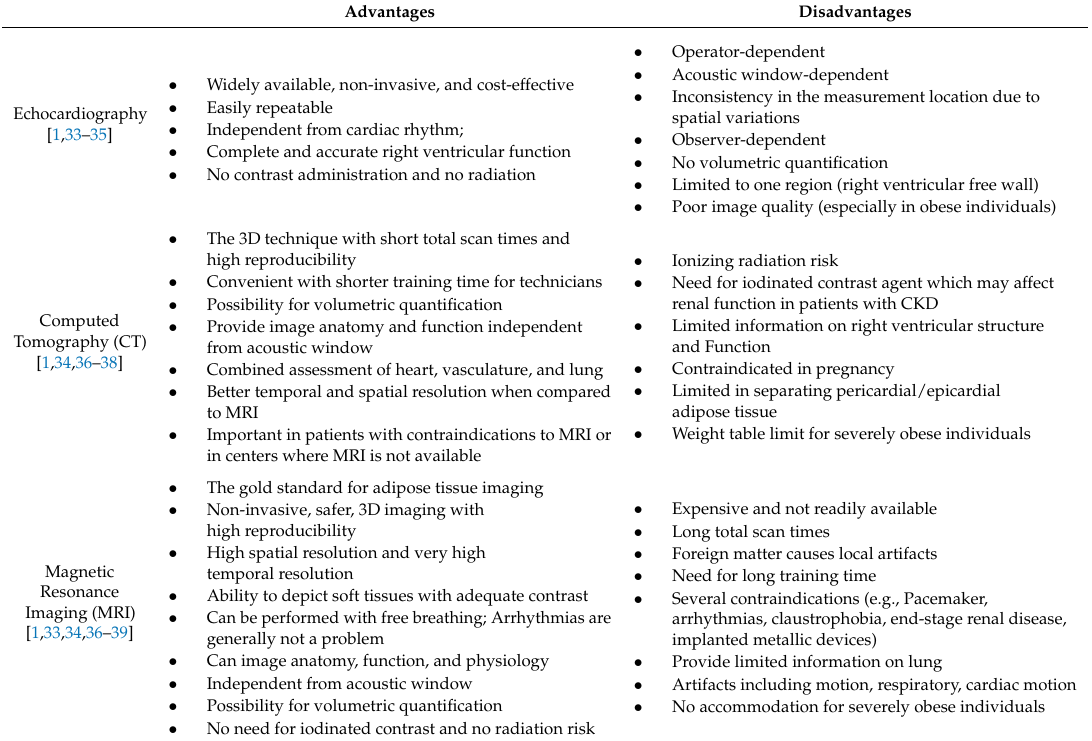
Table 1. Salient features of three different EAT measurement